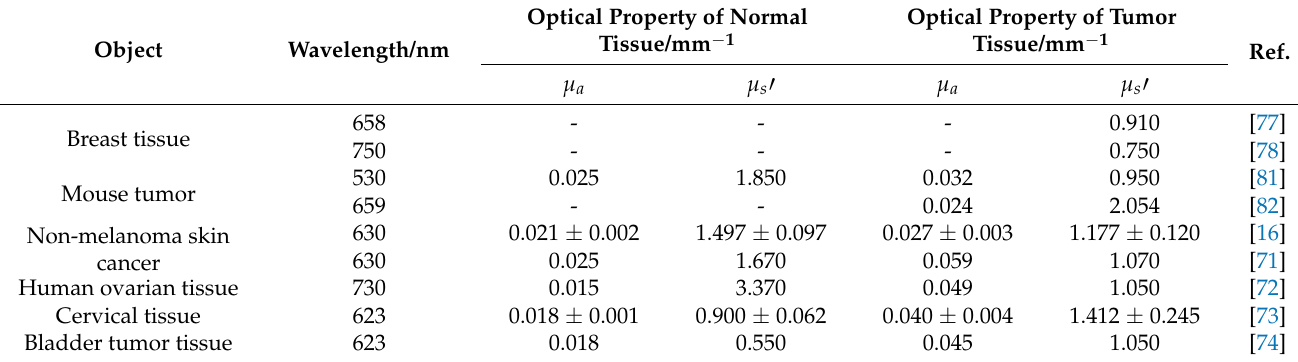
Table 3. Recent studies on detecting tumor by using the SFDI